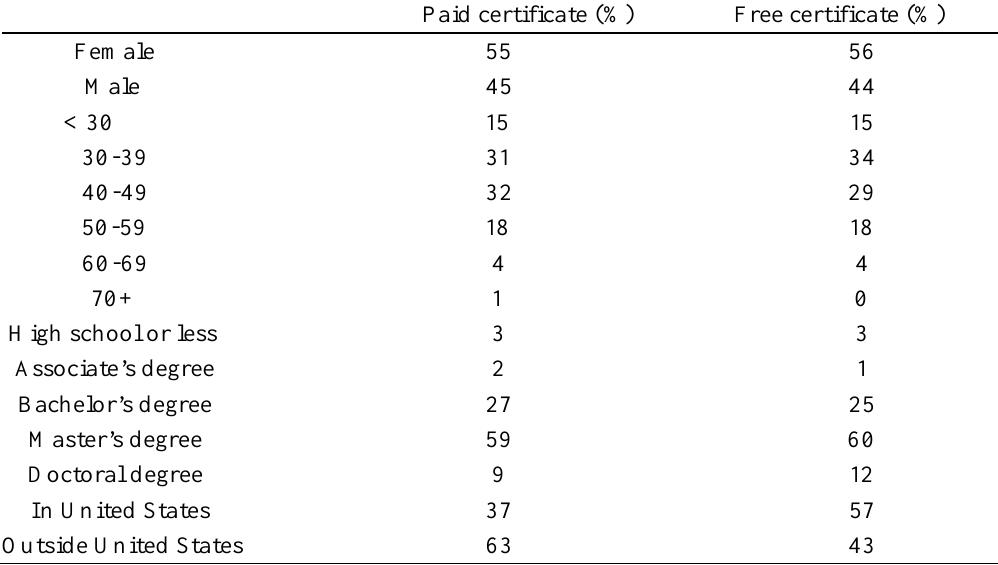
Case Study 1: Demographics of Verified Users in Free- and Paid-Certificate-Track